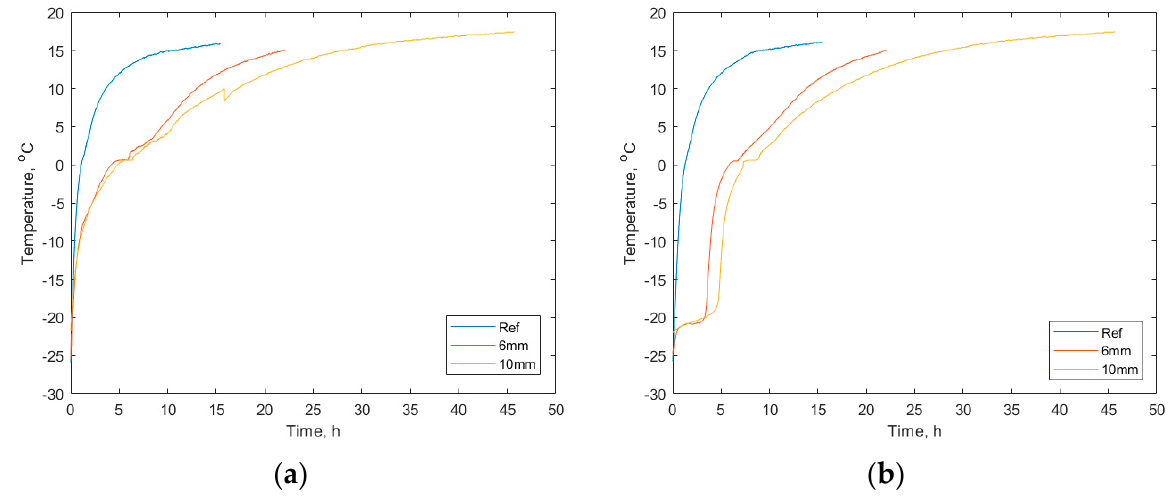
Figure 7. ( a ) The plots of temperature changes at the measurement point T8 (air temperature at the center of climatic room) for the three tested variants of the wall of the refrigerated trailer; ( b ) The plots of temperature changes at the T2 (internal wall) measurement point for the three tested variants of the wall of the refrigerated trailer.